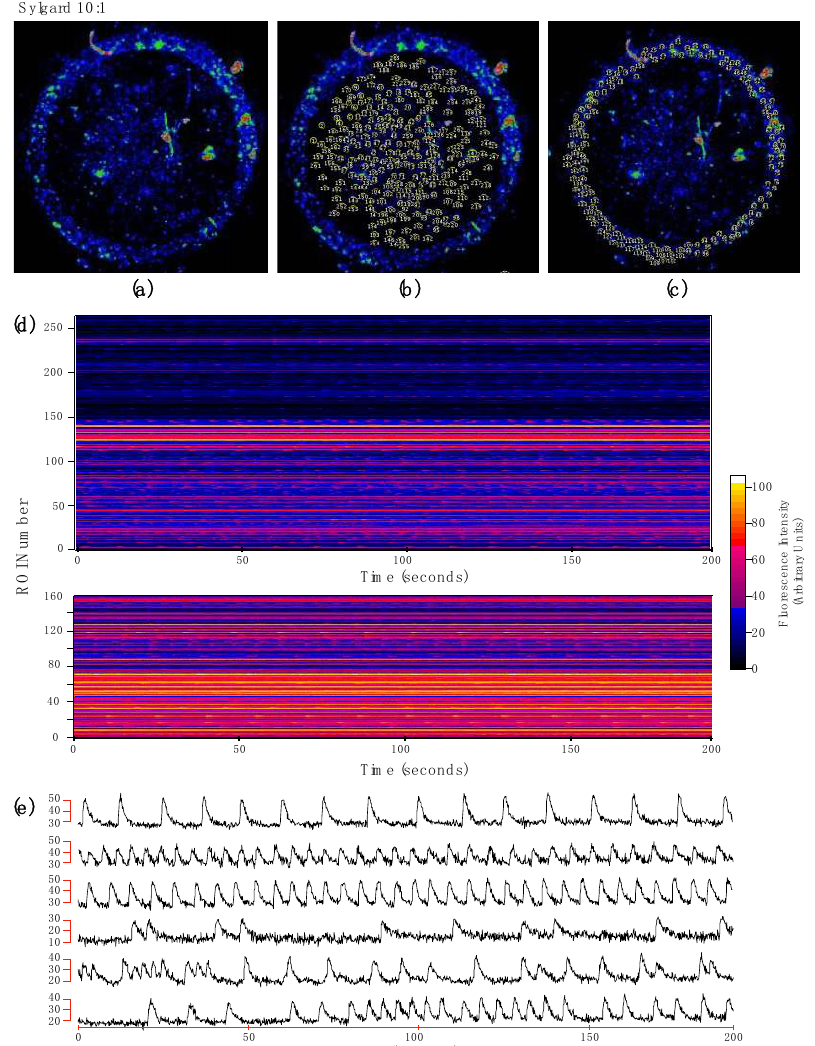
Figure 4. Embryonic cardiomyocytes cultured in stiff PDMS ( a ) SD image corresponding to the cardiomyocytes cultured in stiff PDMS. Movies were acquired with a stereoscopic microscope (2X). Fluorescence intensity of Ca 2+ signals of embryonic cardiomyocytes labeled with calcium green-1 grown on a PDMS microscaffold of proportion 1:10. Selection of regions of interest (ROI) from the optical recordings for the study over 200 seconds in the center of the ring ( b ) ring channel ( c ). ( d ) Multicell (raster chart) summarizes the variations of Ca 2+ activity over the time of 269 ROIs (upper panel) and 150 ROIs (lower panel). The ordinate axis represents the ROI number of the region marked in ( b ) and ( c ) (one ROI per row). The recording time is plotted on the abscissas, the intensity of the fluorescence for each region shown according to the color scale on the right side, the intensity is in arbitrary units (AU). ( e ) Representative examples of the intracellular calcium traces extracted from the ROIs shown in (b) and ( c ). The traces show the differences in intensity as well as the asynchrony of the calcium responses.